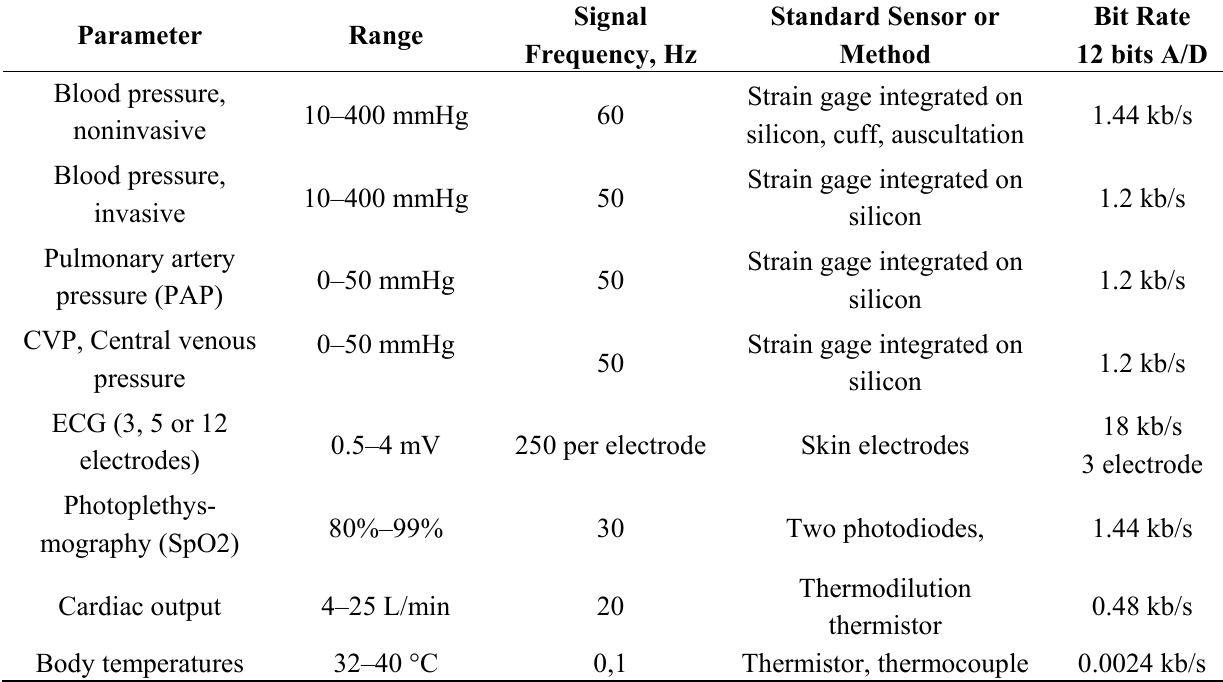
Table 1. Medical parameters monitored by